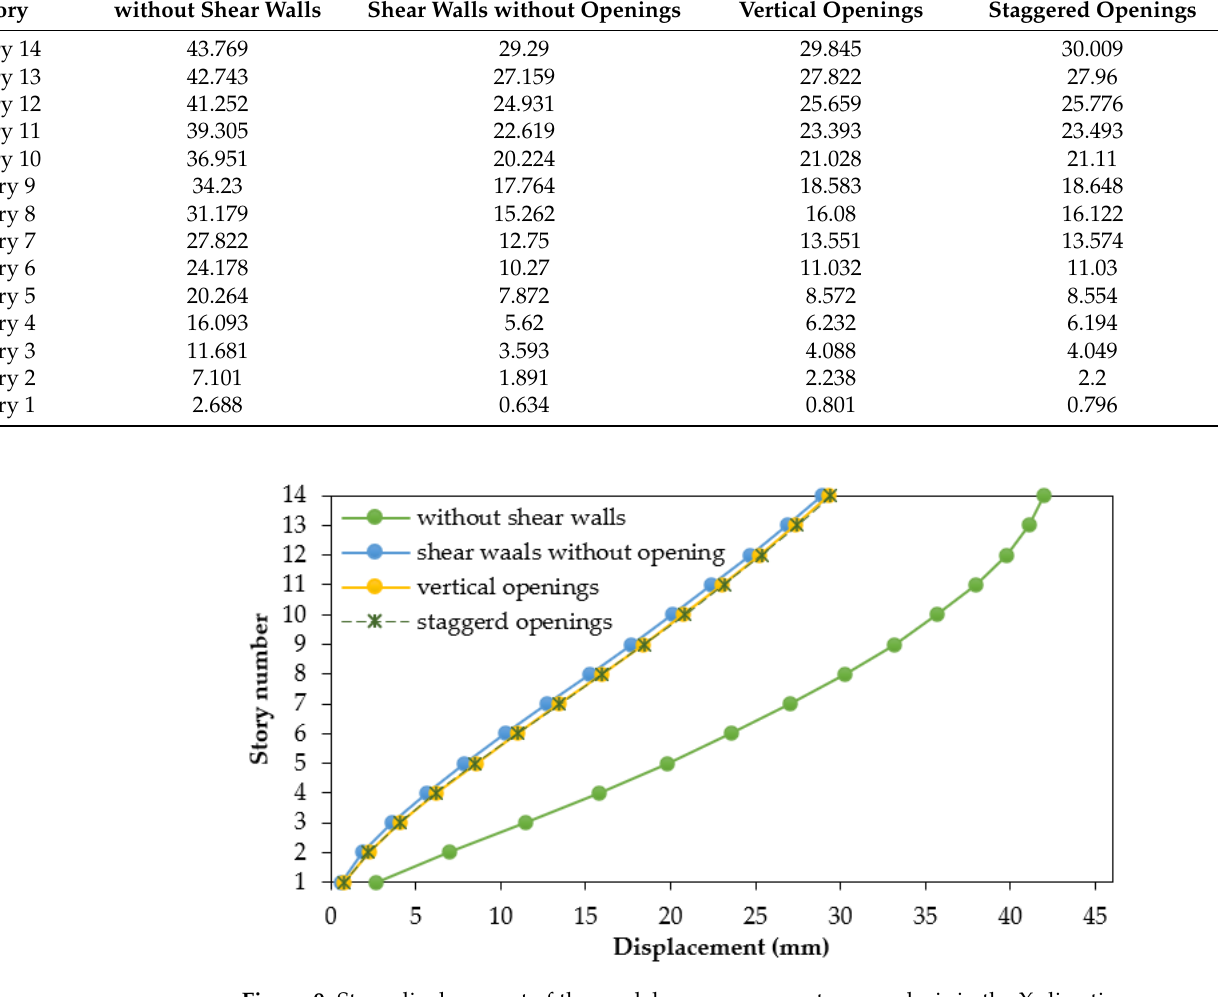
Figure 9. Story displacement of the models, response spectrum analysis in the X-direction.